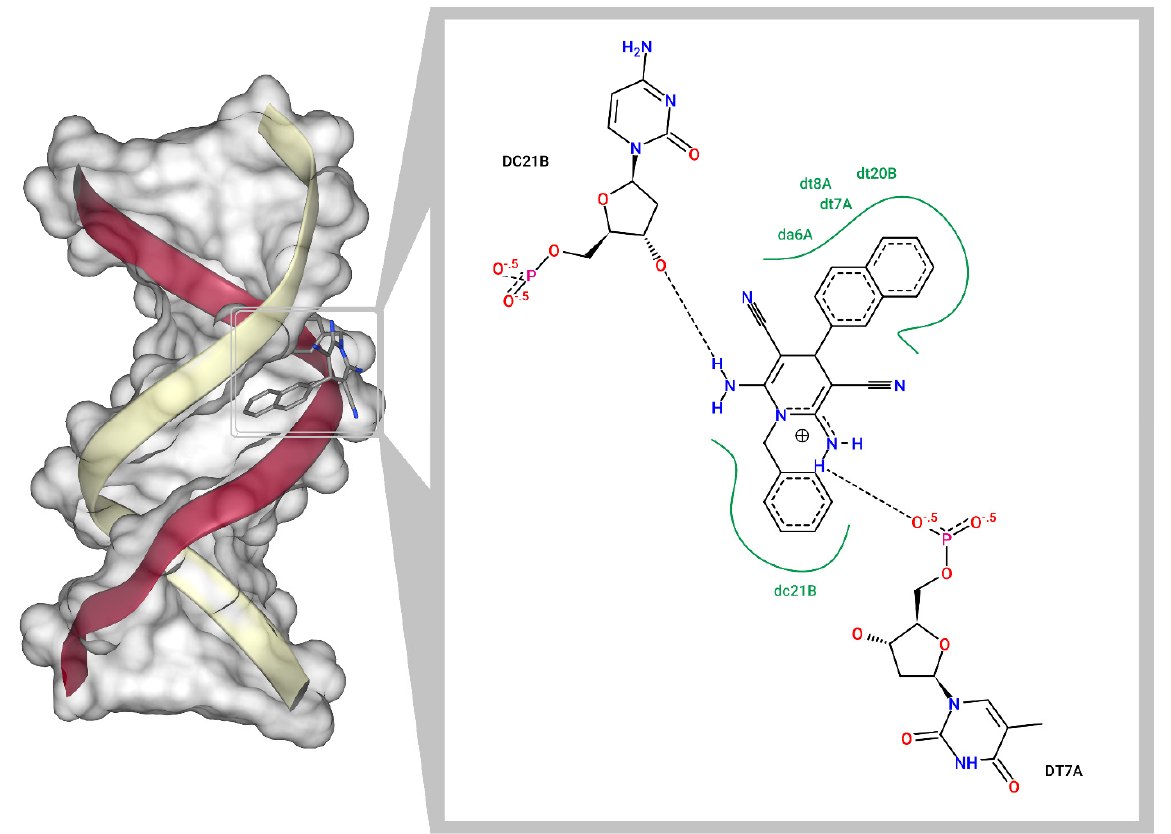
Figure 7. Confirmation of the binding of the most potent compound 4d with the minor groove of DNA through in silico studies.